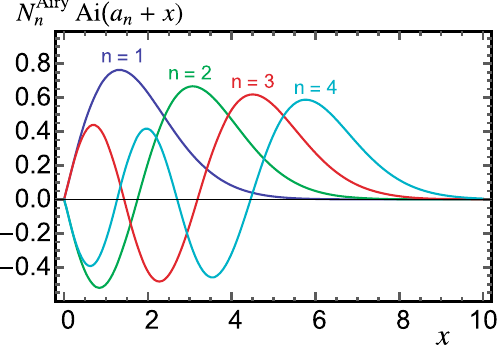
Fig. 2 Normalized solutions to the Airy Schrödinger equation in Eq. (11) in arbitrary units of length four states. The wave functions for different excited states are related, up to normalization, by shifts in their argument. The normalization factor N Airy n is independent of m Q and σ